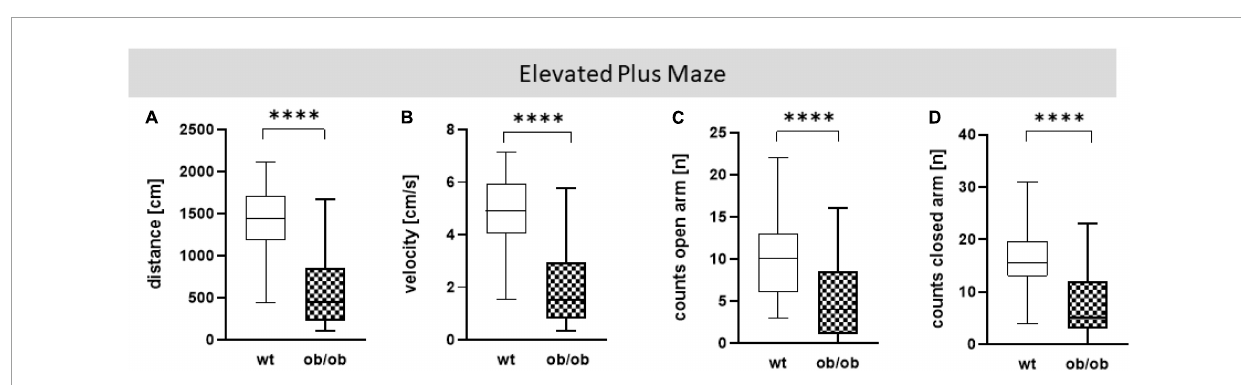
FIGURE4 Elevated Plus Maze (EPM) analysis. (A) Moved distance (cm), (B) mean velocity (cm/s), (C) number of visits (counts) on open arm (n), (D) number of visits (counts) in closed arm (n). Analyses were done with the EthoVision software. The group size was as follows: n (wt) = 45 (A–C) and 44 (D) , n (ob/ob) = 45. Significance of differences between the groups were tested by unpaired Student’s t -test. Statistical significance was set at ∗∗∗∗ p <